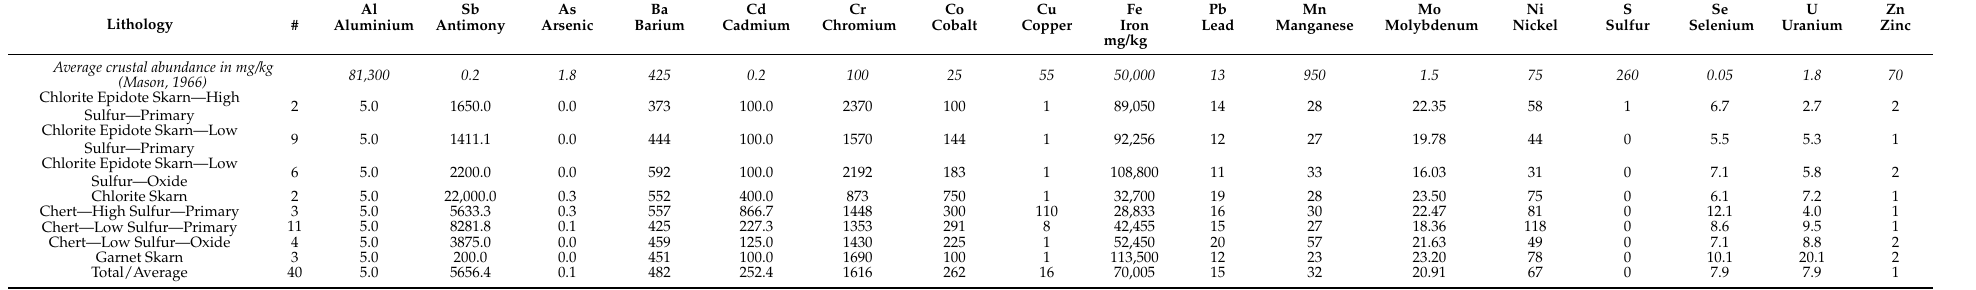
Table 6. Whole Rock analysis, Hzradan waste